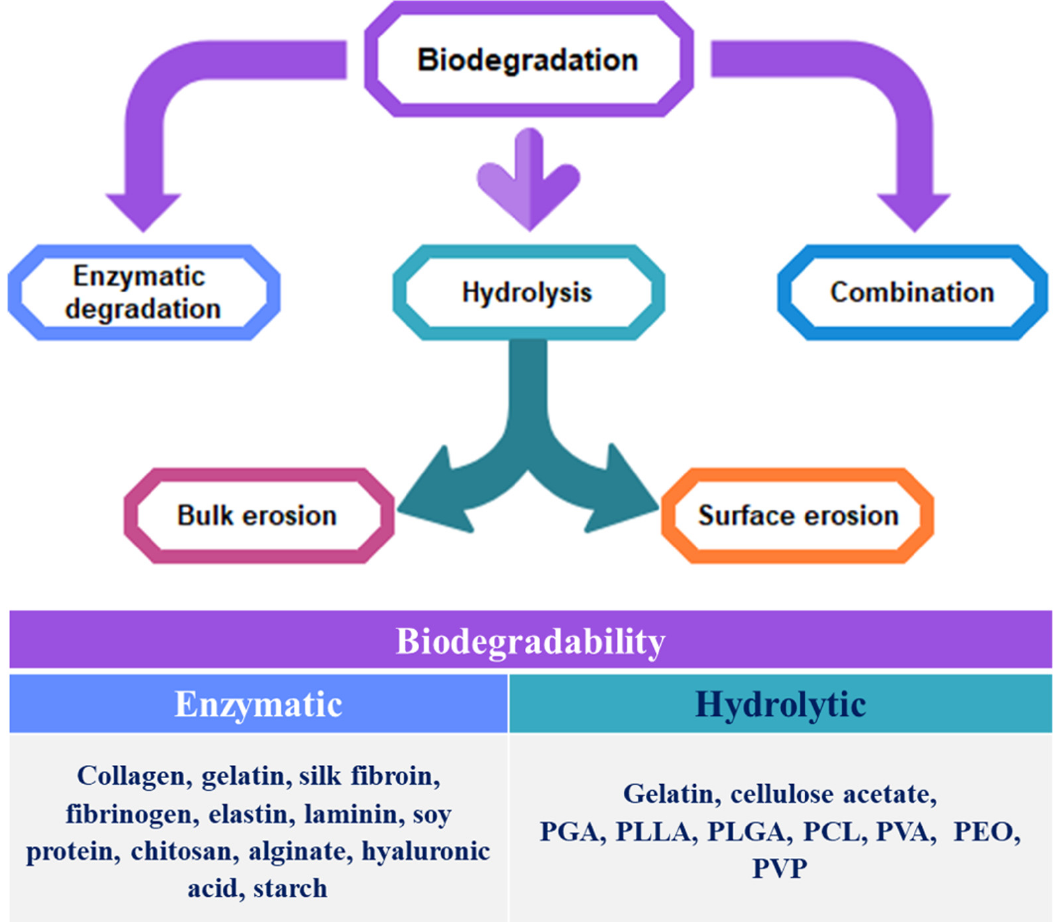
Figure 4. Biodegradation mechanisms of natural and synthetic polymers.